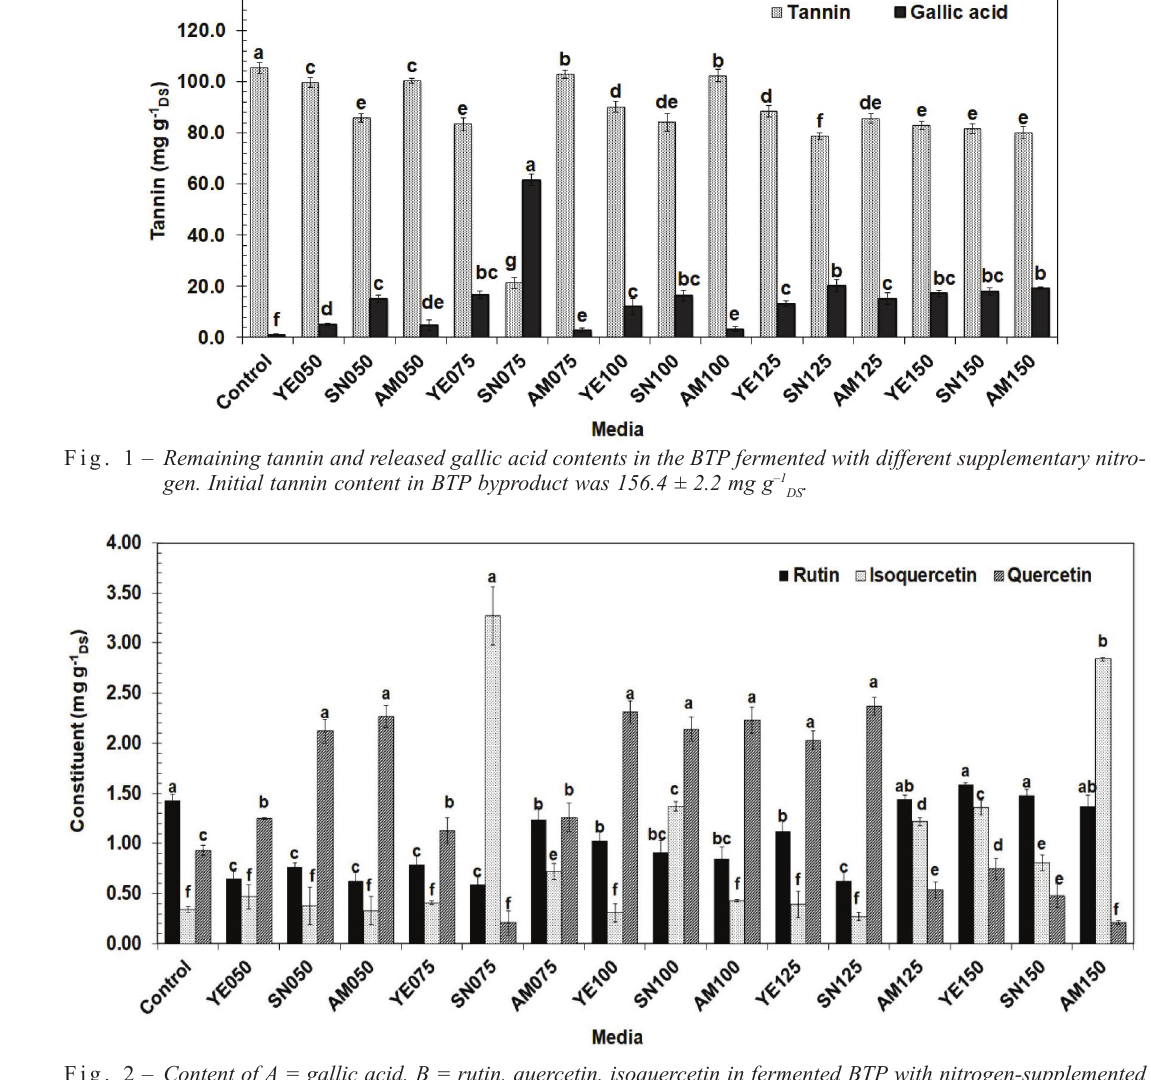
Fig. 2 – Content of A = gallic acid, B = rutin, quercetin, isoquercetin in fermented BTP with nitrogen-supplemented conditions. Initial rutin content of BTP = 5.30±0.03 mg g –1 DS